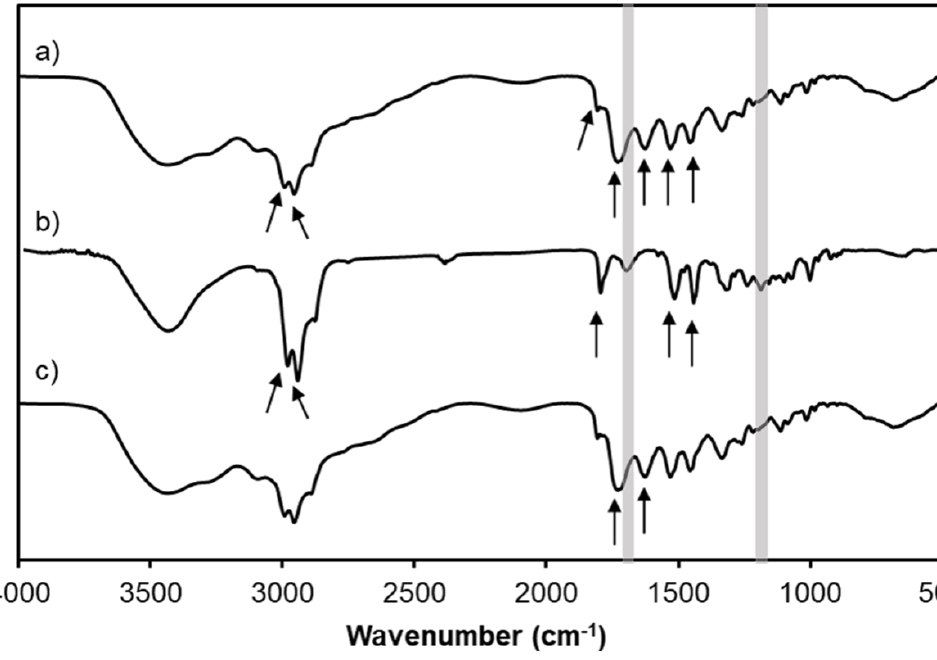
Figure 5. FT-IR spectra of ( a ) oil / PAMAM G4.0; ( b ) Marjoram essential oil and ( c ) PAMAM G4.0.